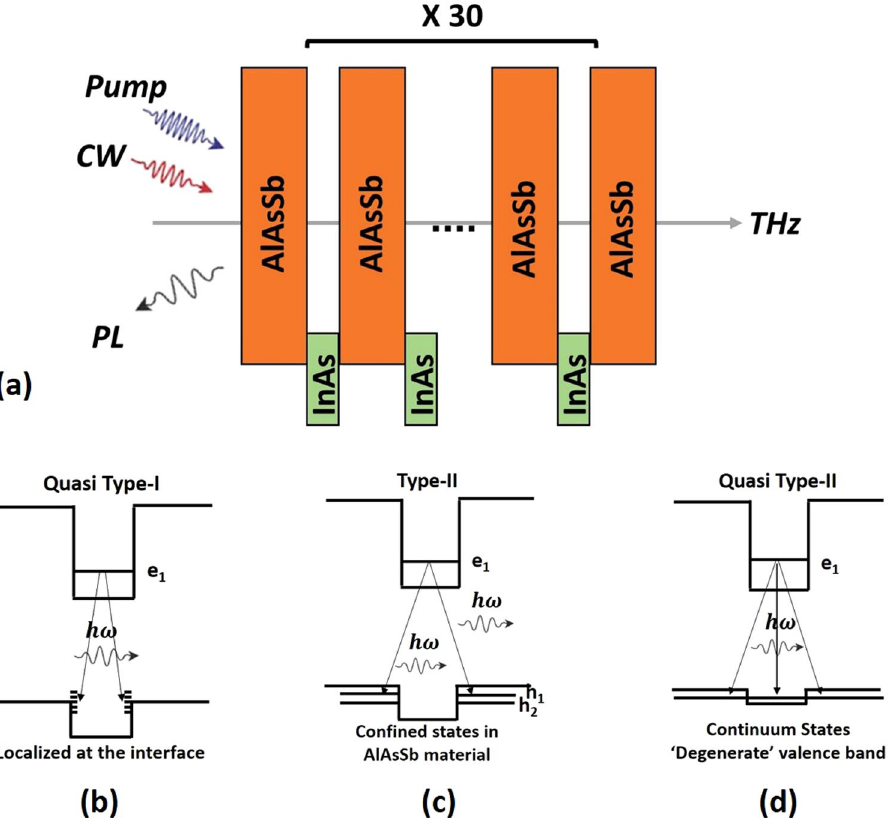
Figure 1. ( a ) Schematic of experimental geometry illustrating the orientation of the pulsed pump and THz probe, as well as, the CW excitation and PL emission of the InAs/AlAsSb MQW structure. ( b ) Quasi-type-I recombination at T < 100 K dominated by quasi direct transitions between holes localized by interface inhomogeneities and electrons in the QW. ( c ) Pure Type-II transitions between electron in QW and holes in the barrier. ( d ) The quasi-type-II situation in which transitions to the less-confined and continuum states for holes dominate at high